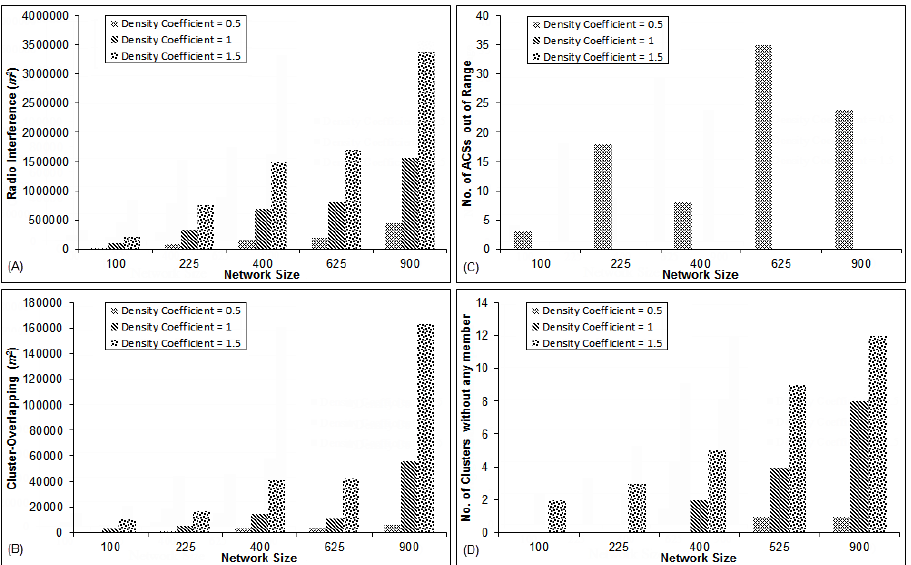
Figure 8. Radio interference (A), cluster-overlapping (B), no. of ACSs out of range (C), and no. of clusters without any member (D) at different